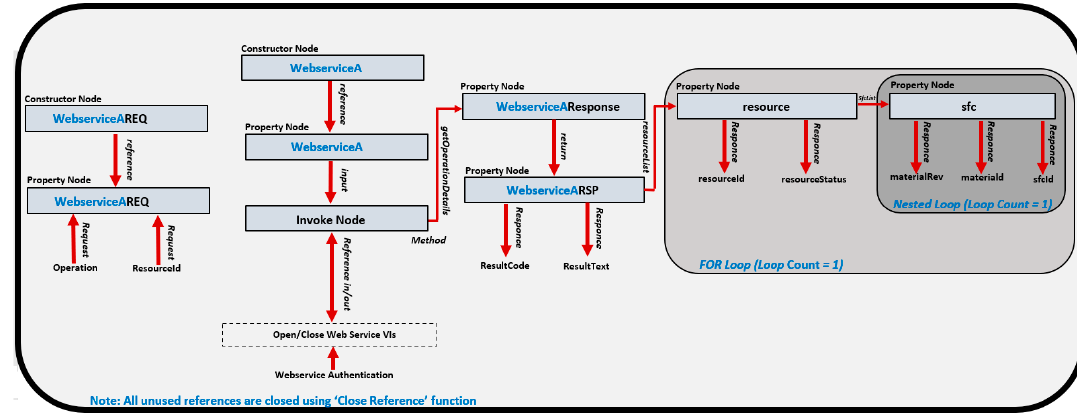
Figure 5. Block diagram to edit LabVIEW VI of imported webservices.